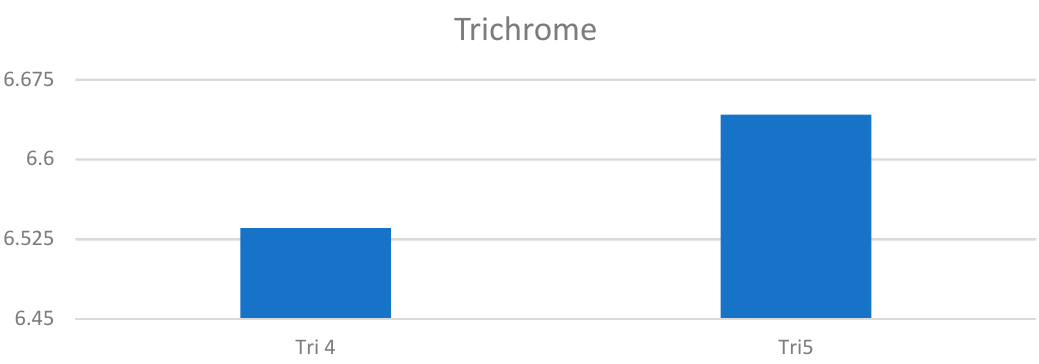
Figure 17. The comparison of specimens stained with trichrome before and after the treatment revealed 27.8% rise in collagen concentration.